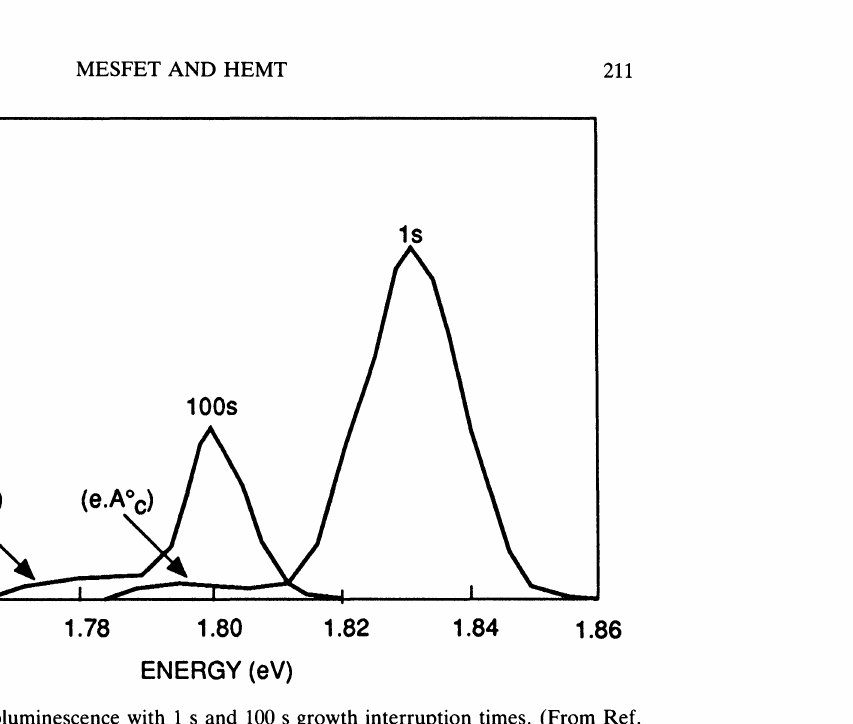
FIGURE 4 2 nm OW photoluminescence with and 100 growth interruption times. (From Ref.